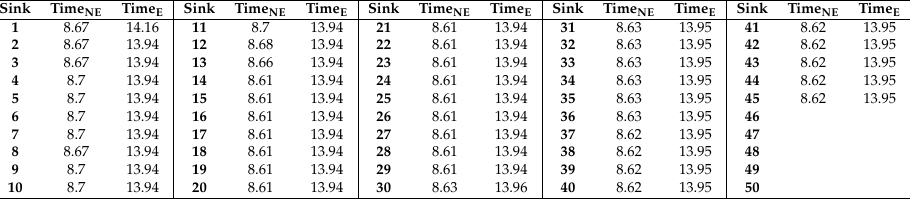
Table A2. Scenario 2: transmission times (in s) for each sink all over the transmission line. (Distance between poles is equal to 50 m, κ = 45, η = 1, NE means no encryption, E means encryption.)